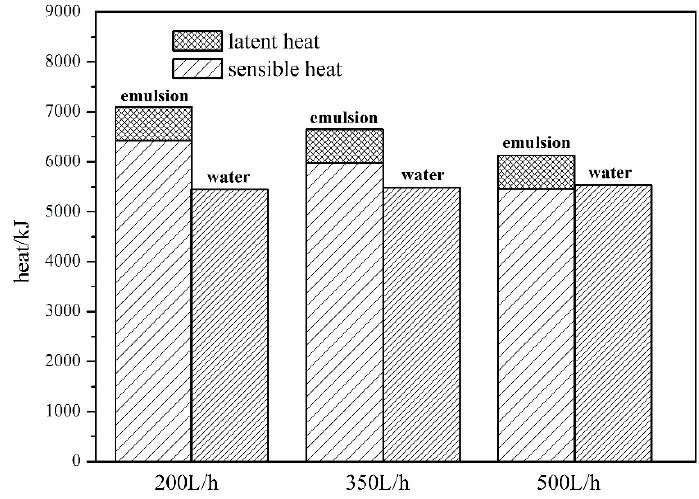
Figure 16. Heat storage under di ff erent flow rates.